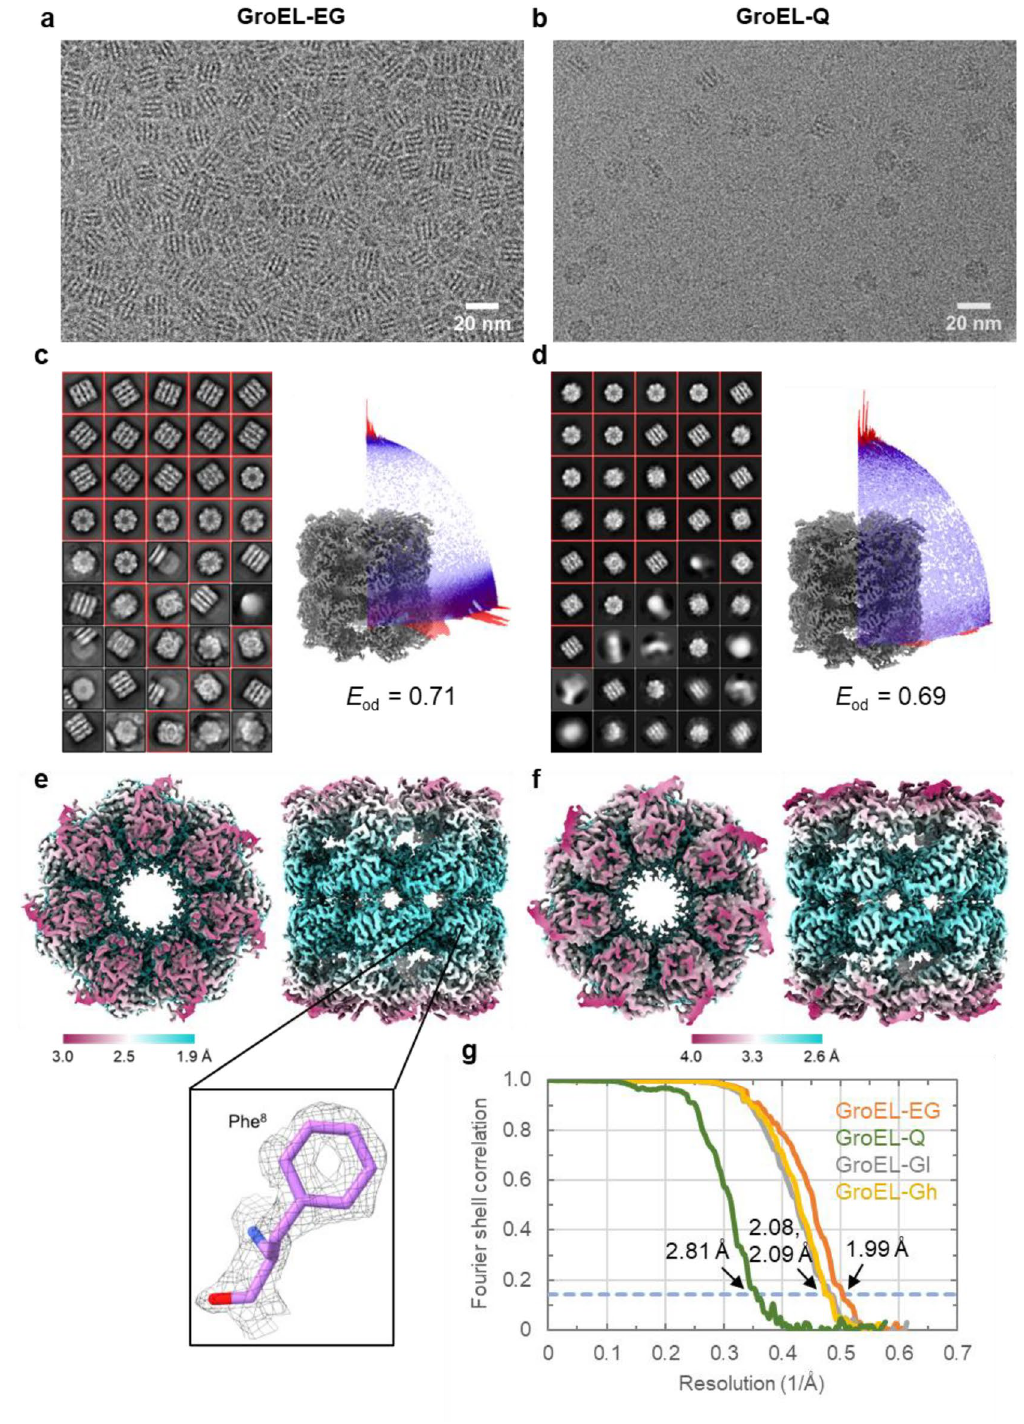
Figure 2. CryoEM image analyses of GroEL on the EG-grid and holey carbon grid. ( a and b ) Typical cryoEM images of GroEL on the EG-grid (GroEL-EG) ( a ) and on the glow discharged Quantifoil grid (GroEL-Q) ( b ). ( c and d ) 2D class averages from the GroEL-EG ( c ) and GroEL-Q ( d ) dataset. The class averages are aligned in descending order of particle numbers from left to right and top to bottom. The classes selected for the following analysis are indicated with red boxes. Right panel shows angular distribution of particles used in the final refinement for each dataset. Final 3D maps are shown for reference. The efficiencies ( E od ) calculated with cryoEF are also shown. ( e and f ) Two orthogonal views of the final 3D map from the GroEL-EG ( e ) and GroEL-Q ( f ) dataset: top view, left panel; and side view, right panel. The local resolution distribution is colored as in the color bar. The inset shows the density map and the fitted model (PDB: 1SX3) around Phe 8 . ( g ) The FSC curves for the final maps of the GroEL-EG and GroEL-Q dataset. The dashed blue line indicates the FSC = 0.143